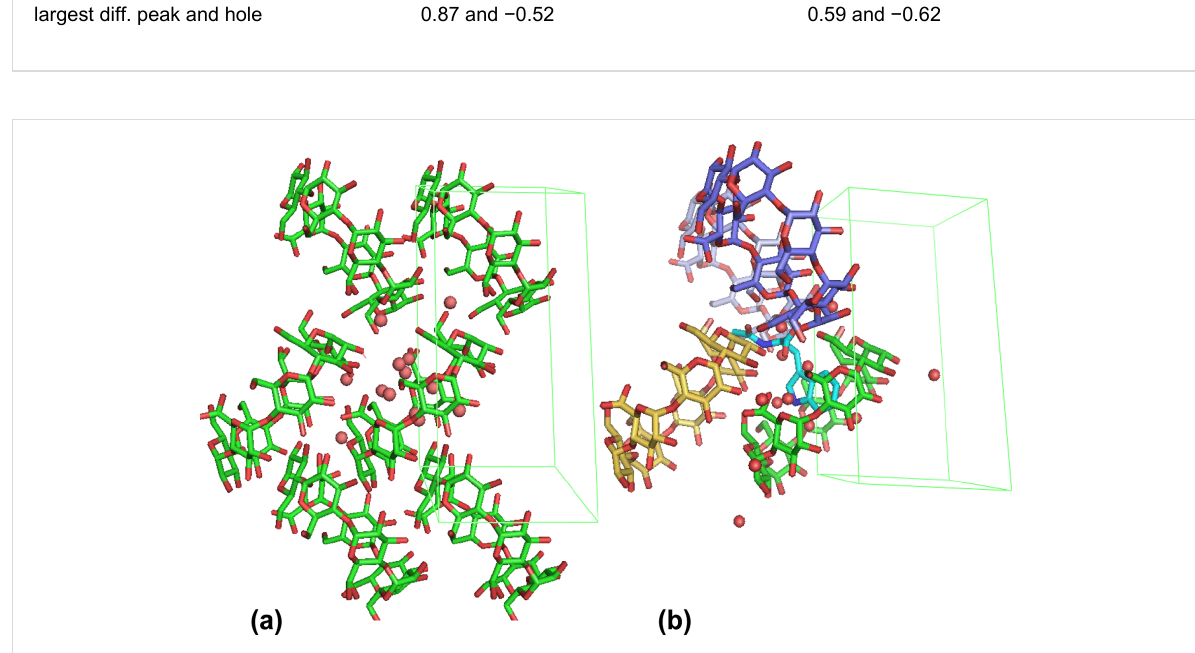
Figure 4: “ β -CD–D-NAcTrp” structure. (a) The herring bone packing of β -CD along the c -axis; (b) The guest (cyan) can be accommodated in the “ β -CD–D-NAcTrp” monomeric structure as indicated by molecular modeling studies (water molecules of the asymmetric unit are shown as spheres).